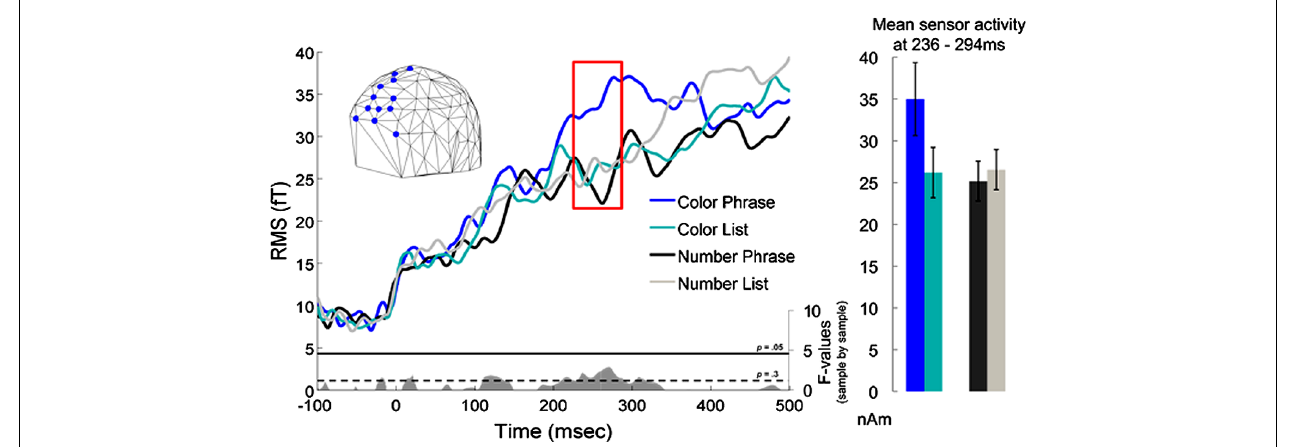
FIGURE 4 | Sensor results for the left anterior octant of the sensor array. As in the ROI results, Color Phrases elicited higher activation than Color Lists, while no similar difference was observed for the Number conditions.The red box indicates the interval during which a marginal interaction cluster was